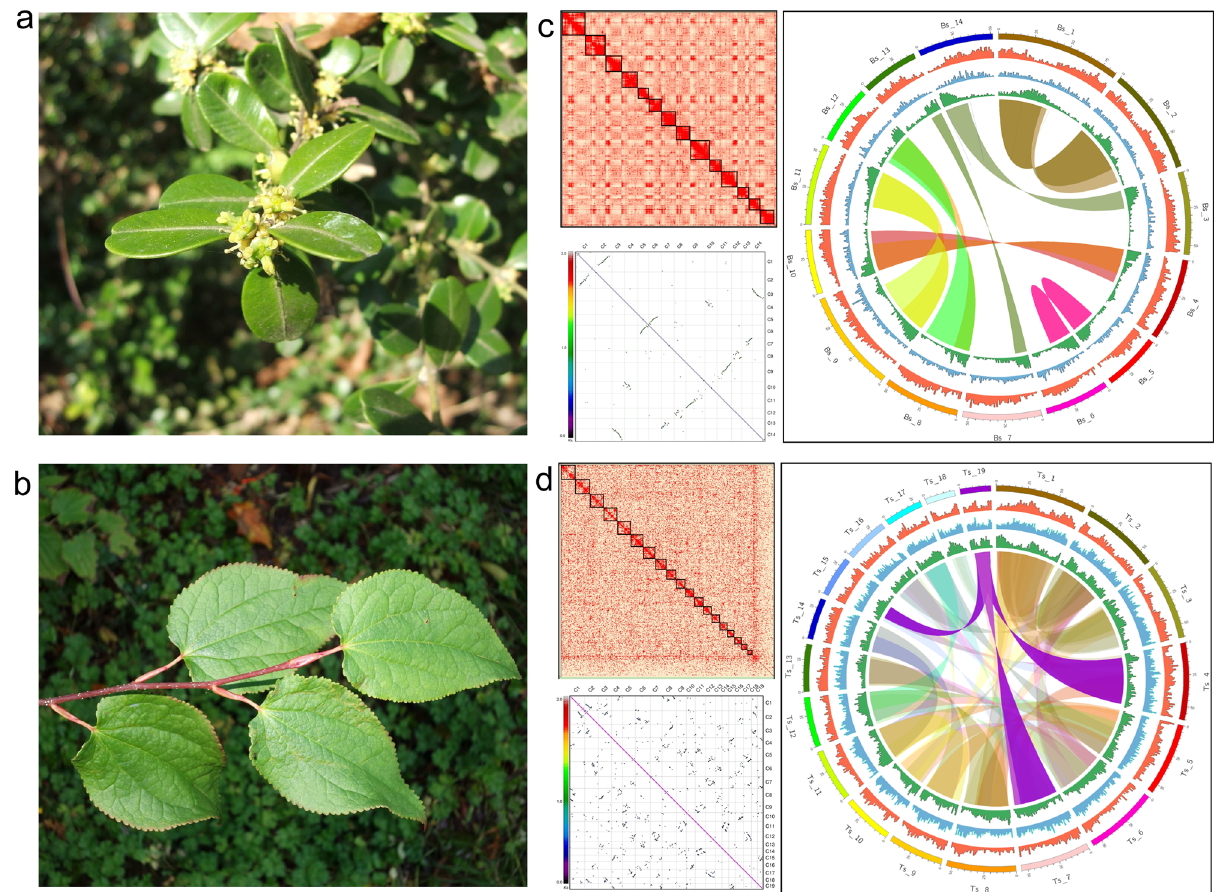
Fig. 1 Habit and genome assembly features of Buxus and Tetracentron . Flowering branch of Buxus sinica ( a ) courtesy of PiPi; and leafy shoot of Tetracentron sinense ( b ) courtesy of Daderot. Hi-C contact heatmaps, intragenomic synteny with syntenic blocks colored according to the Ks scale, and Circos plots for Buxus ( c ) and Tetracentron ( d ). Concentric tracks in the Circos plots, from innermost outwards, show gene, Copia , and Gypsy retrotransposon densities per 1 Mb, and chromosomes, while ribbons connect inter-chromosomal syntenic regions. Source data underlying Fig. 1c, d are provided as a Source data fi